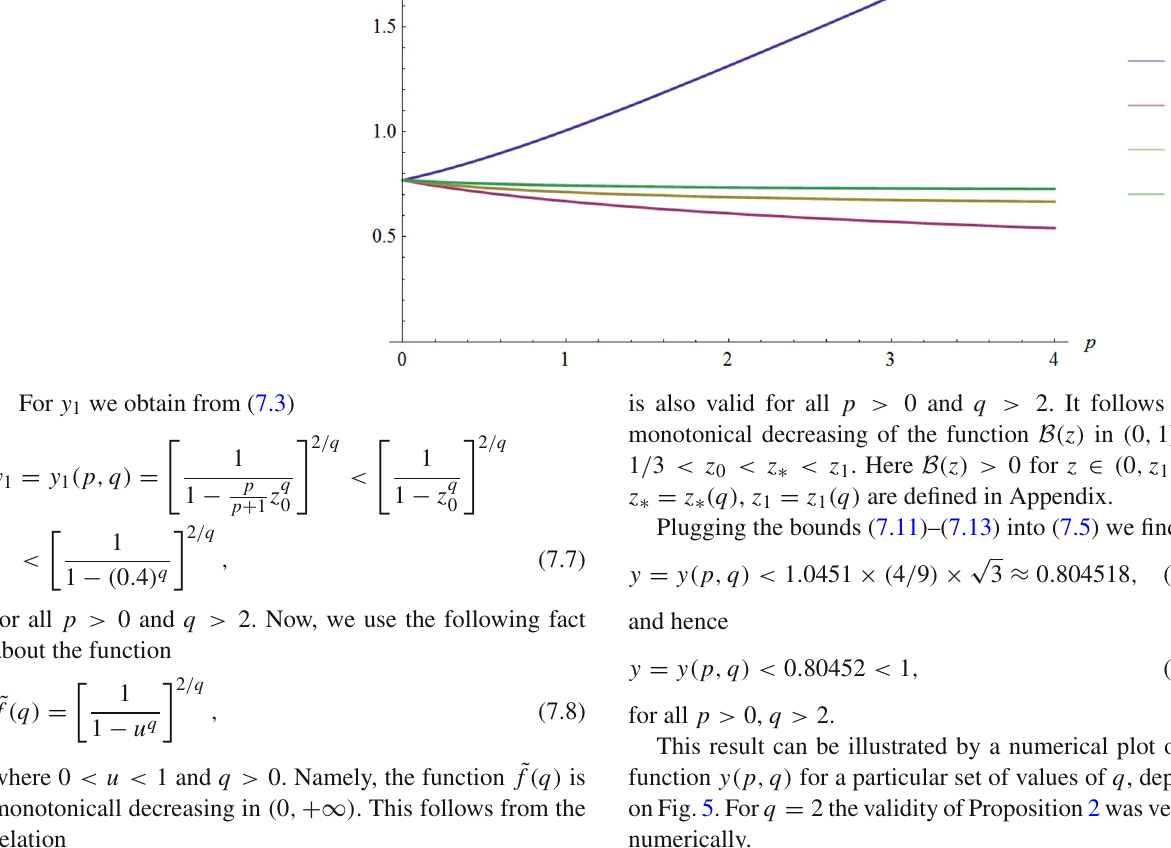
Fig. 5 The graphical representation of the function y ( p , q ) for q = 1 , 2 , 3 ,